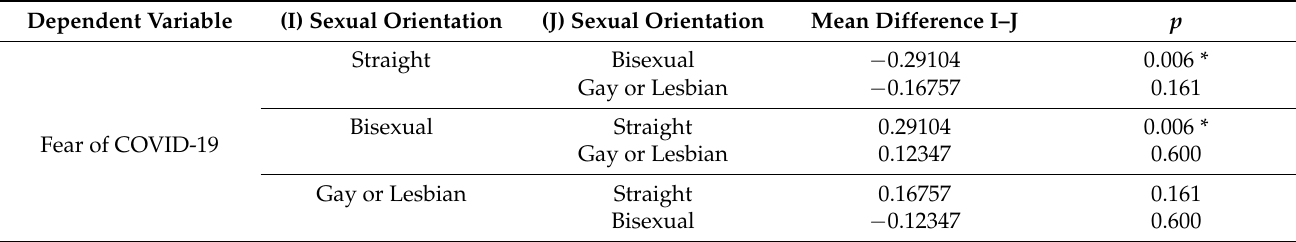
independent samples t -test demonstrated no statistically significant differences by gender